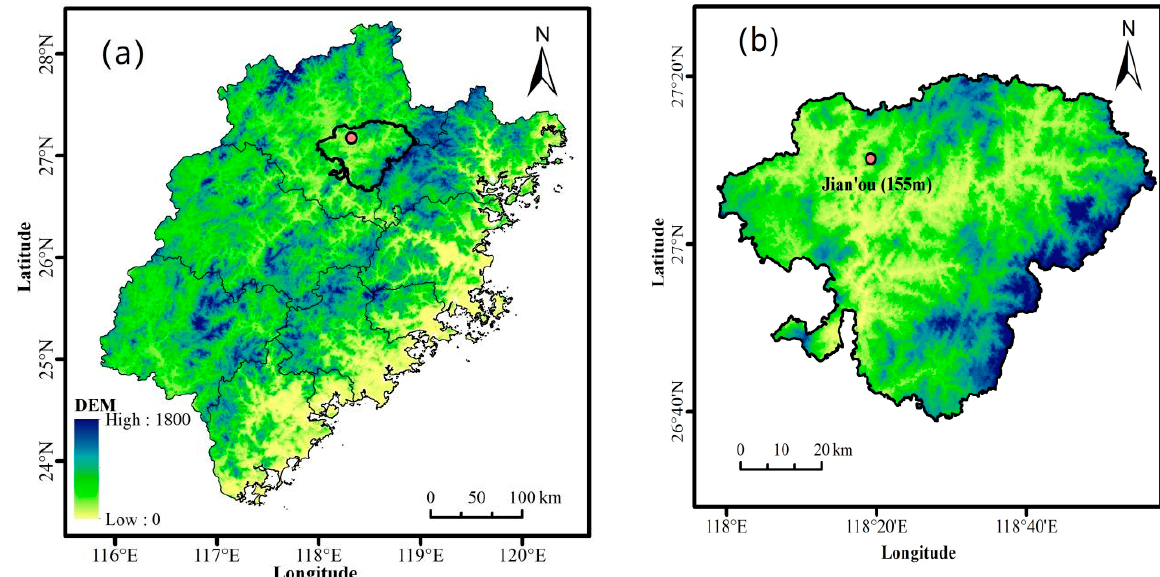
Figure 1. Geographical map of study area (( a ) is Fujian Province, ( b ) is Jian’ou Station).